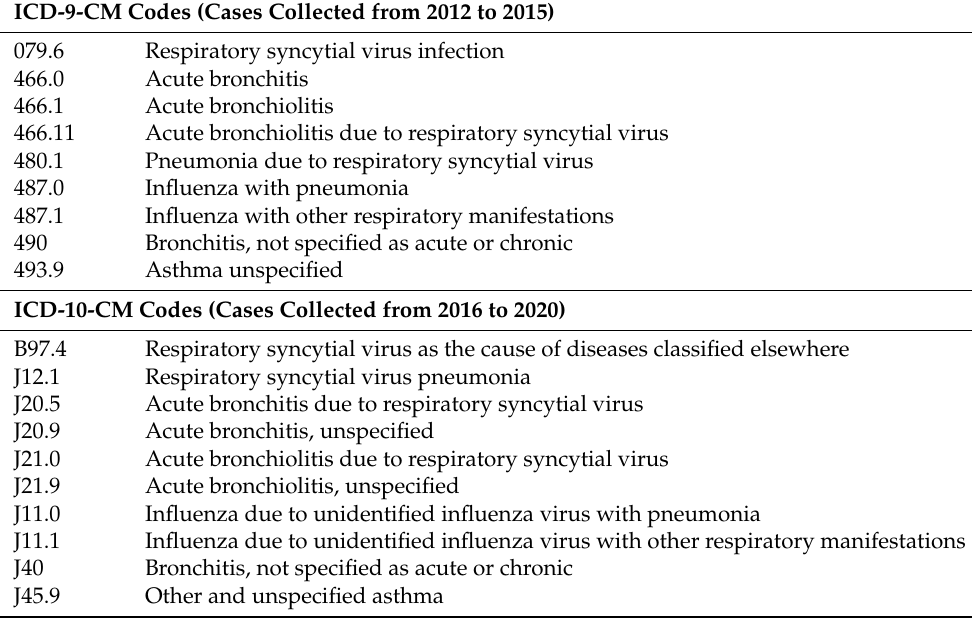
Table 1. Definition of respiratory system diseases used according to the ICD-9-CM and ICD-10-CM